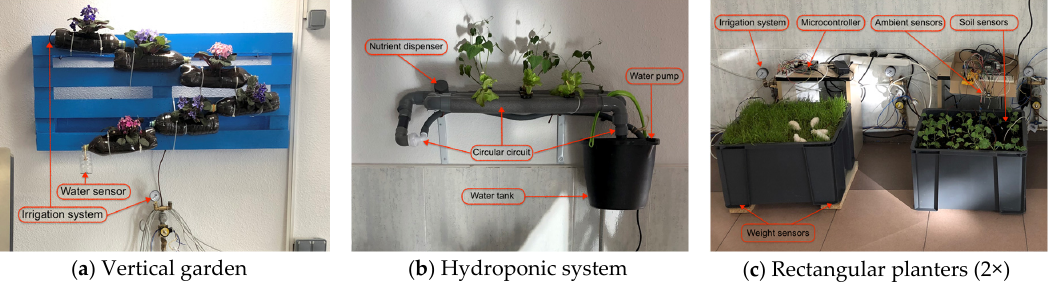
Figure 1. Internet of Things (IoT) planters installed in the campus.